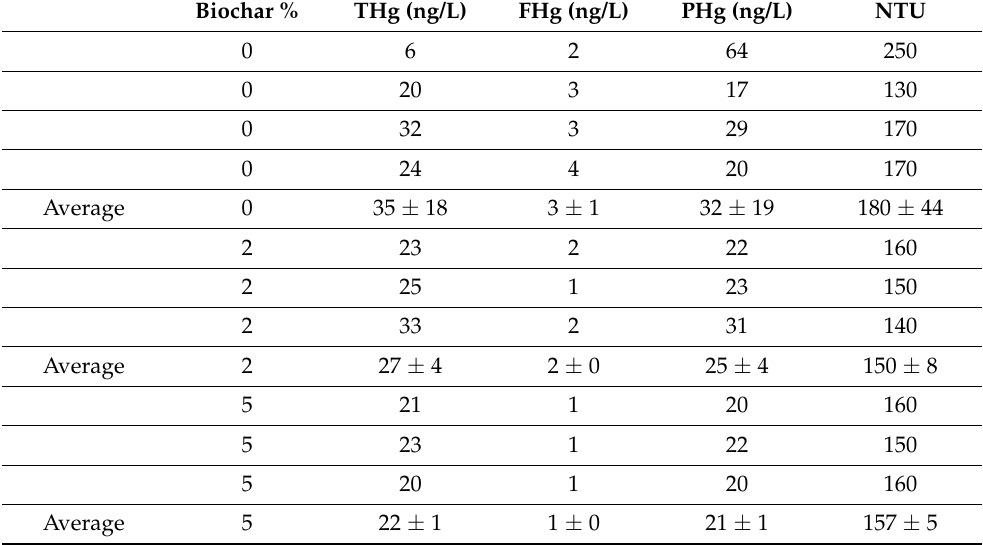
Table 1. Twenty-four-hour storm water column results from Malakoff Diggins, analyzed for total (THg), filtered (FHg), and particulate-bound (PHg)